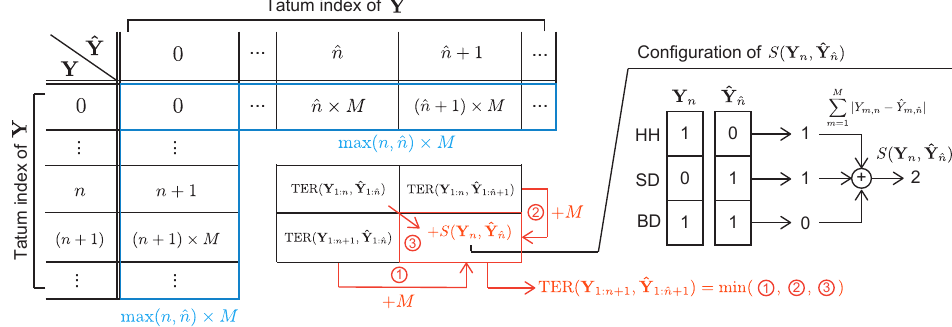
Figure 6. Computation of tatum-level error rate (TER) based on dynamic